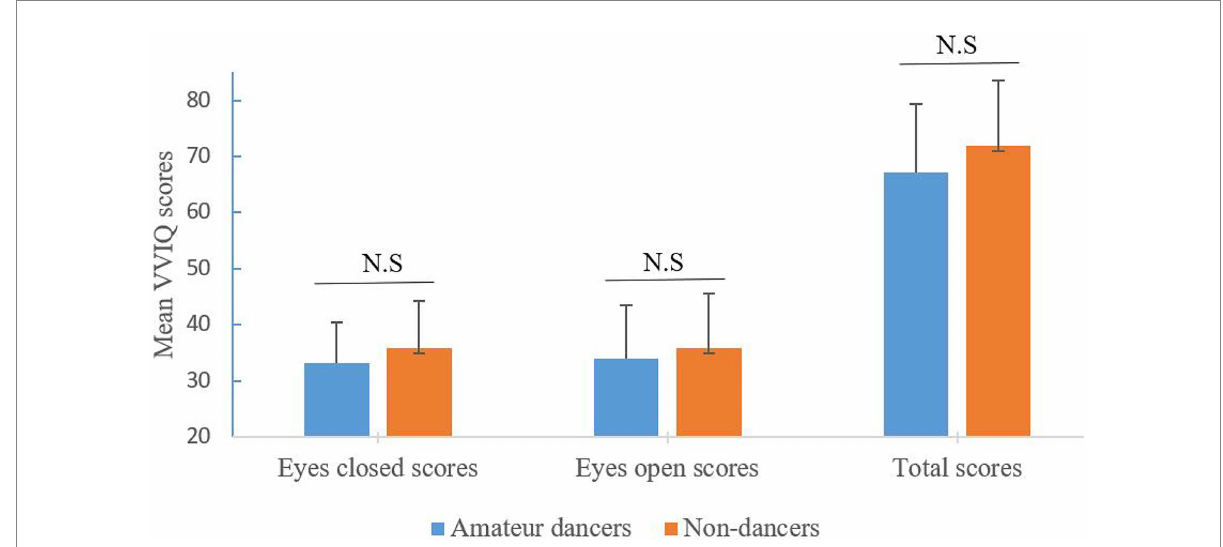
FIGURE 1 Individual differences in mean VVIQ scores between amateur dances and non-dancers. N.S indicates no significant difference, p > 0.05.